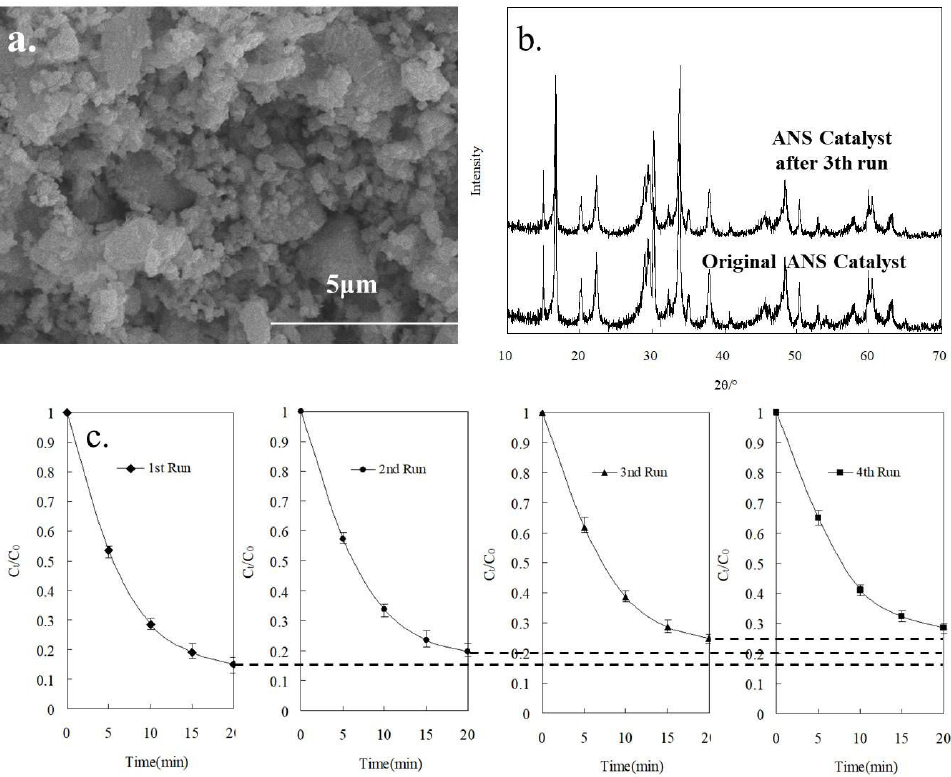
Figure 10. (a) The morphology of catalyst after 3rd photocatalysis experiment ; (b) The XRD patterns of ANS Catalyst before and after 3rd photocatalysis experiment; (c) the degradation curve of ANS catalyst reuse under visible